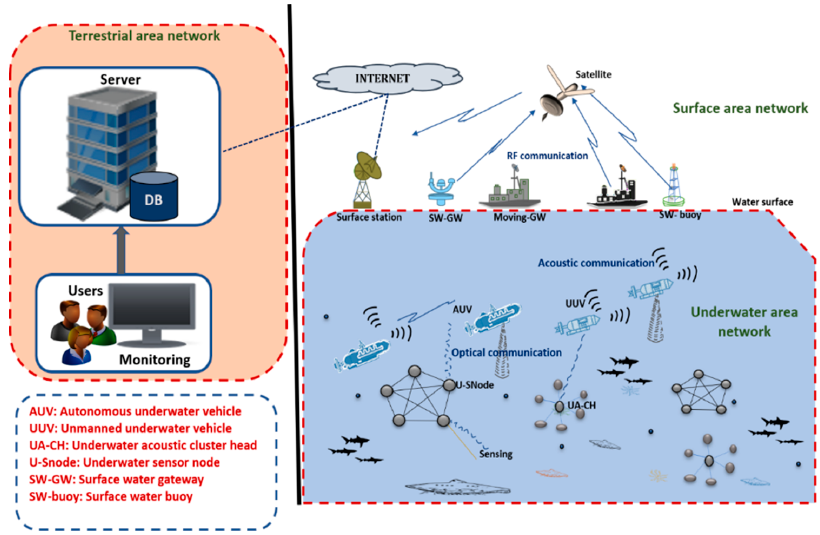
Figure 1 . General underwater architecture and communication technologies. Figure 1. General underwater architecture and communication